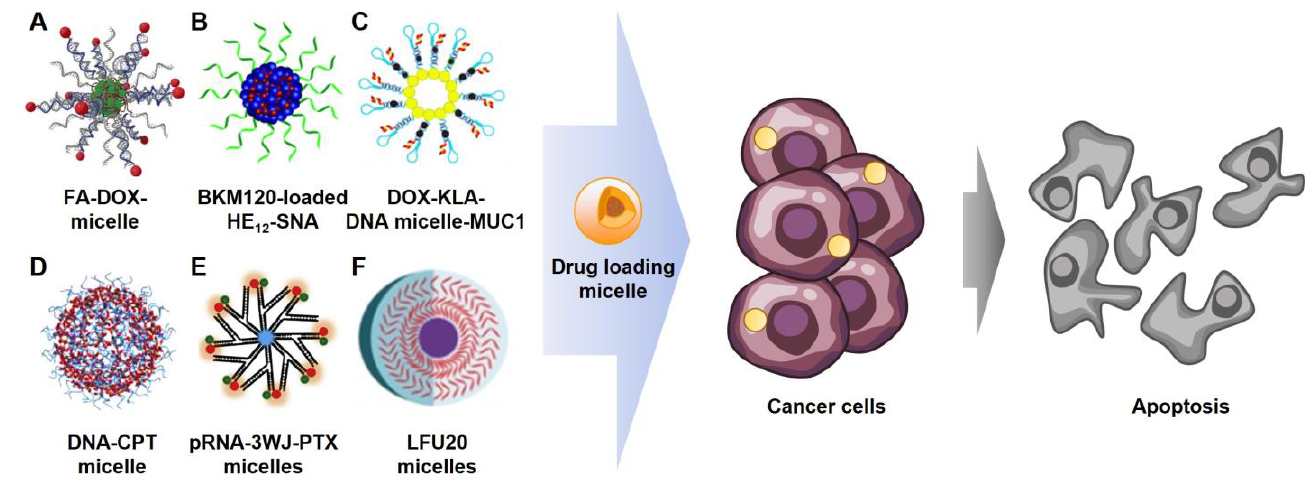
Figure 6. Diverse chemotherapeutic micelles. ( A ). Folic acid (FA) functionalized and doxorubicin (DOX) loaded micelle (ref. [45]) ( B ). Buparlisib (BKM120) loaded micelle (ref. [53]) ( C ). Mucine1 aptamer (anti-MUC1) functionalized, and (KLAKLAK)2 (KLA) and DOX loaded micelle (ref. [39]) ( D ). Camptothecin (CPT) loaded micelle (ref. [28]) ( E ). Paclitaxel (PTX) and anti-MUC1 functionalized micelle (ref. [46]) ( F ). Floxuridine micelle (ref. [54]).